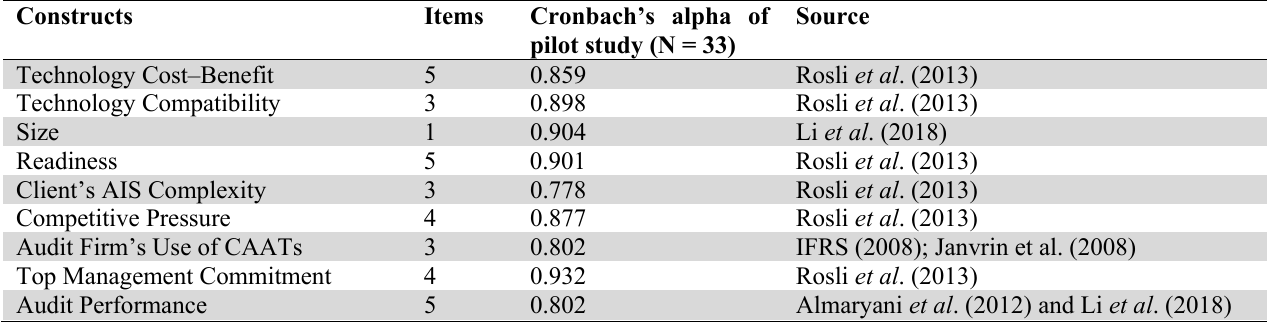
Results of Pilot Study and Source of Measurement